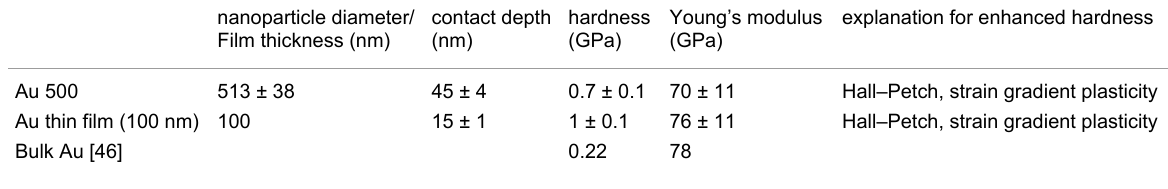
Table 2: Nanomechanical properties of Au nanoparticles and thin film at a maximum load of 80 µN compared to bulk